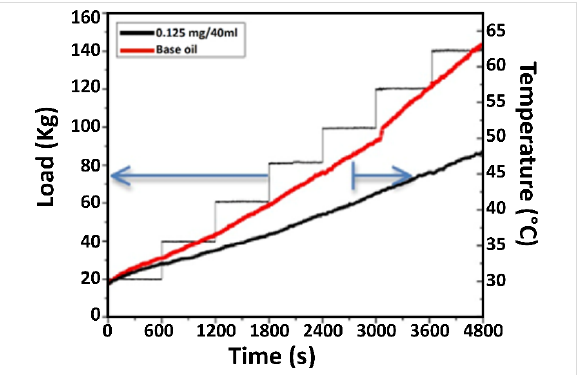
Figure 8: Comparison of the measured temperature of base oil and N-rGO (3 mg/L) nanolubricant as a function of the